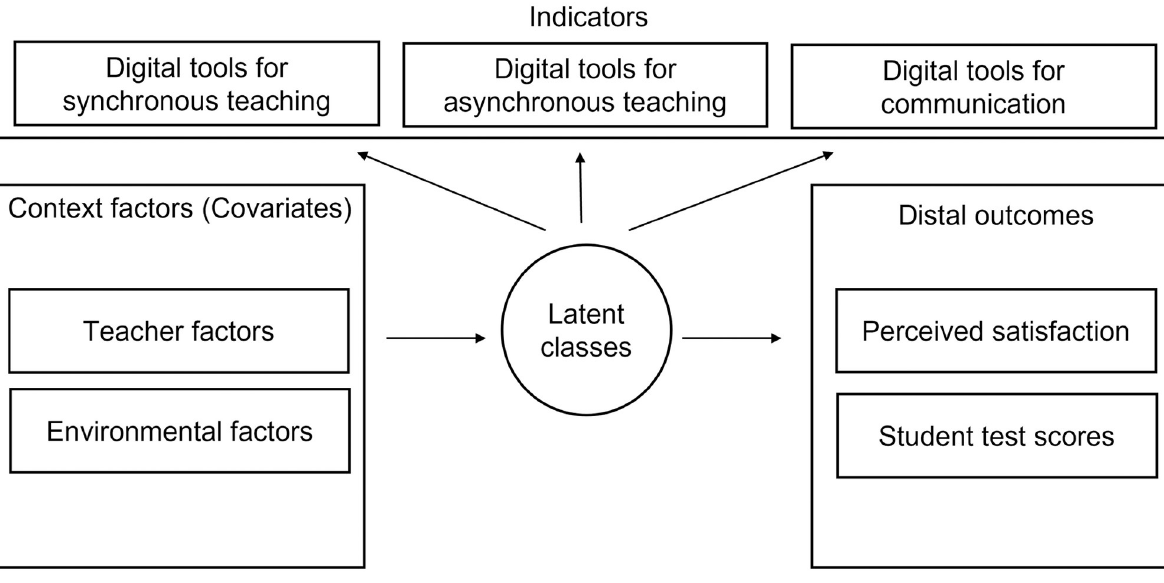
Fig 1. Latent Class Analysis—Measurement